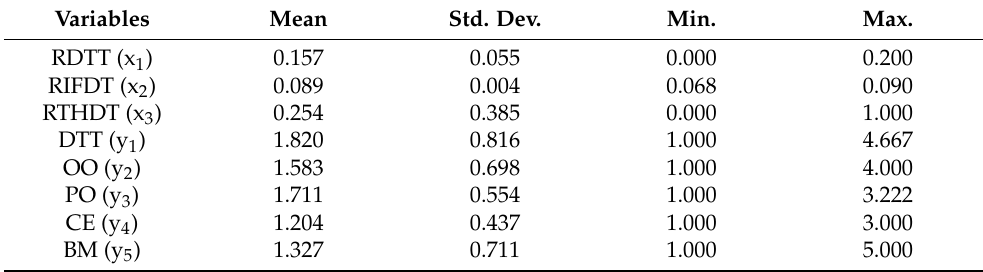
Table 1. Summary statistics of variables ( N =